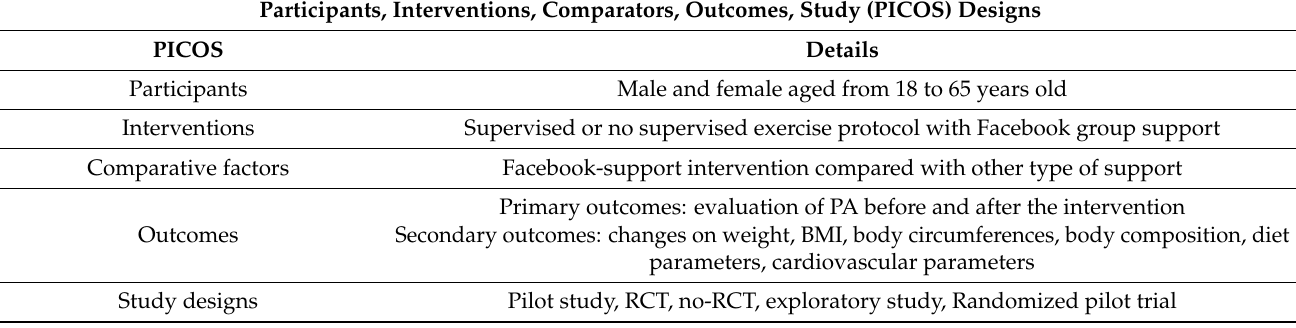
Table 1. Participants, interventions, comparators, outcomes, study (PICOS) model. Participants, Interventions, Comparators, Outcomes, Study (PICOS) Designs PICOS Details Participants Male and female aged from 18 to 65 years old